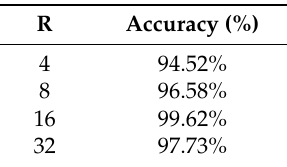
Table 7. Comparison of accuracy with different values of hyper parameter R.